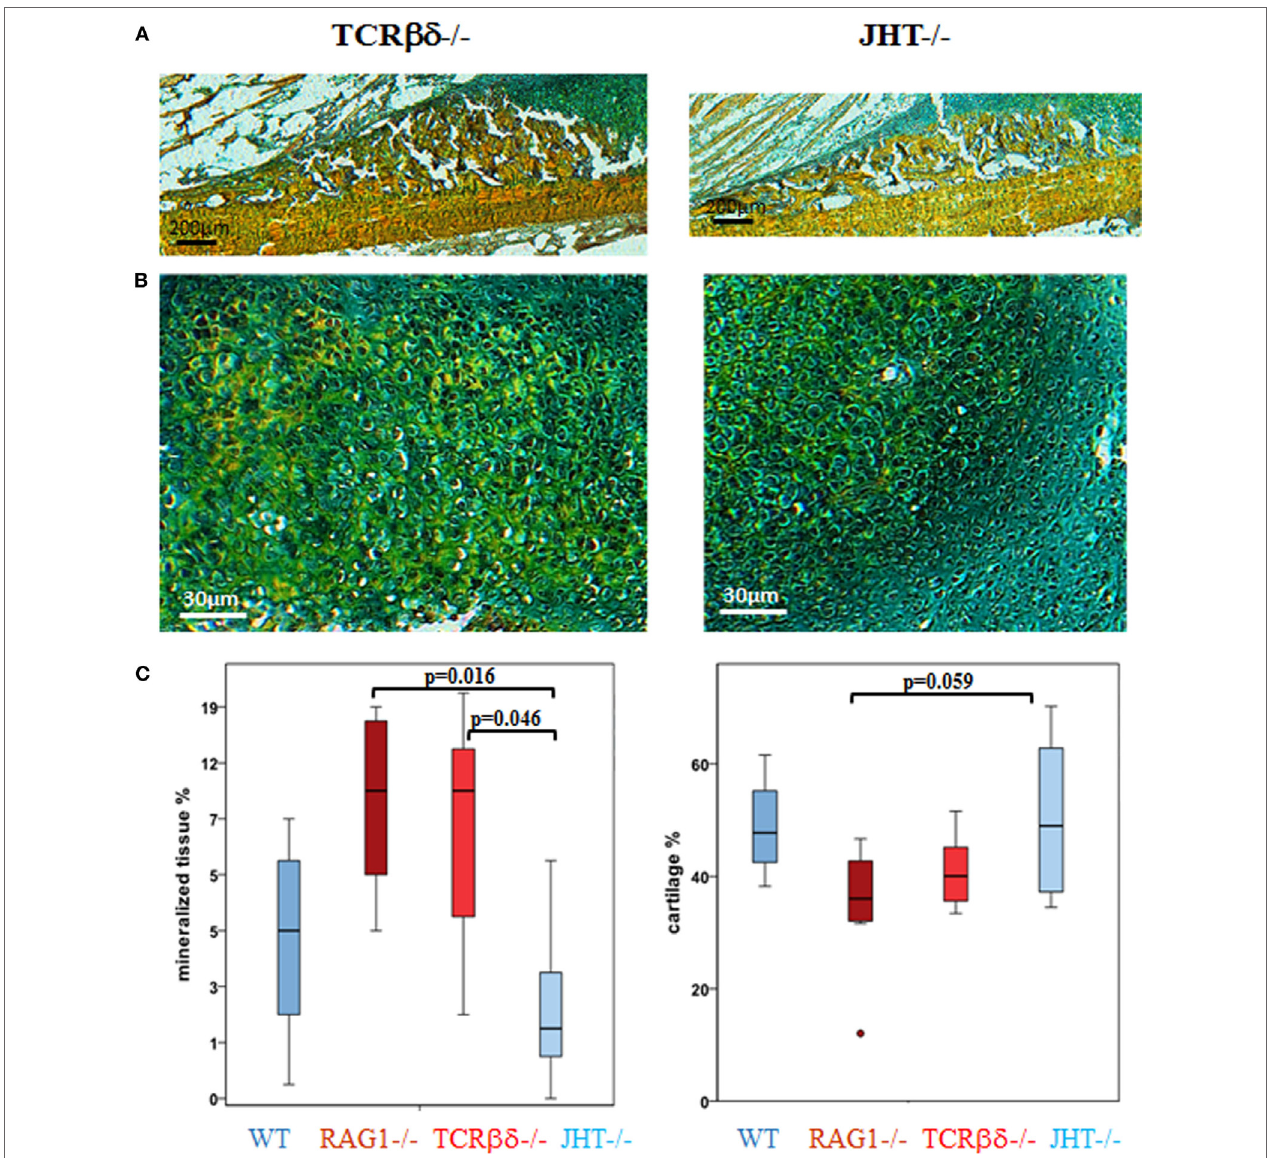
FigUre 8 | single knockouts for either T cells or B cells reveal a distinct healing pattern . In T cell-deficient mice healing resembles recombination activating gene 1 homozygous knockout (RAG1 − / − ) animals, while B cell-deficient mice resemble the wild-type (WT) healing more closely. Movat’s pentachrome staining of fracture healing 7 days into healing revealed an early mineralization in T [T cell receptor β and δ chain homozygous knockout (TCR βδ − / − )] and B [joining region homozygous knockout (JHT − / − )] cell-deficient mice (a,B) that was also seen in RAG1 − / − animals and which exceeds the mineral deposition in B cell-deficient mice. (c) A histomorphometrical analysis of the bone and cartilage tissue in the fracture callus confirmed the similarity in RAG1 − / − and T cell-deficient mice (red) when compared with WT healing and the healing in B cell-deficient mice